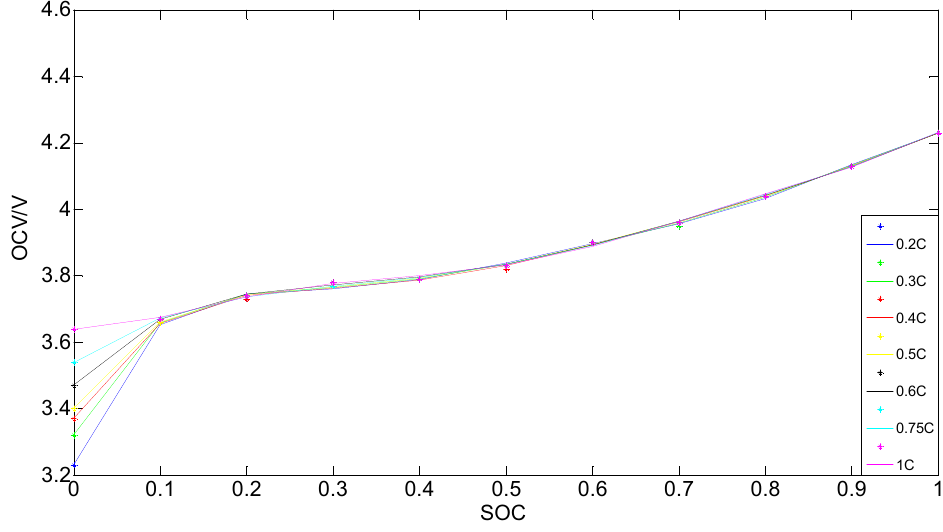
Figure 5. Different OCV ‐ SOC relationships with sixth order polynomial fittings.